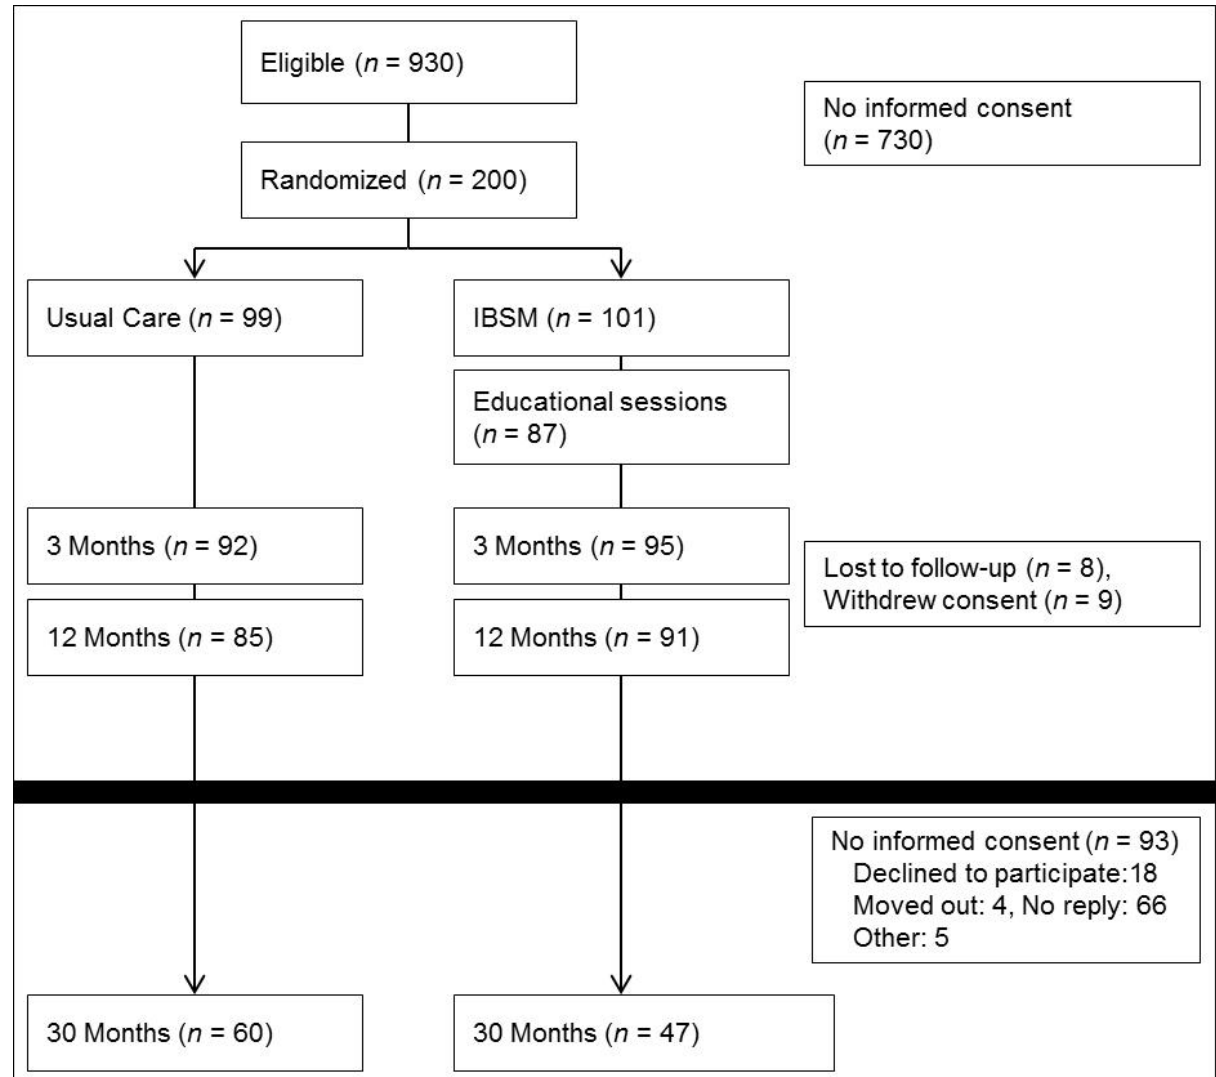
Figure 3. Flowchart of study